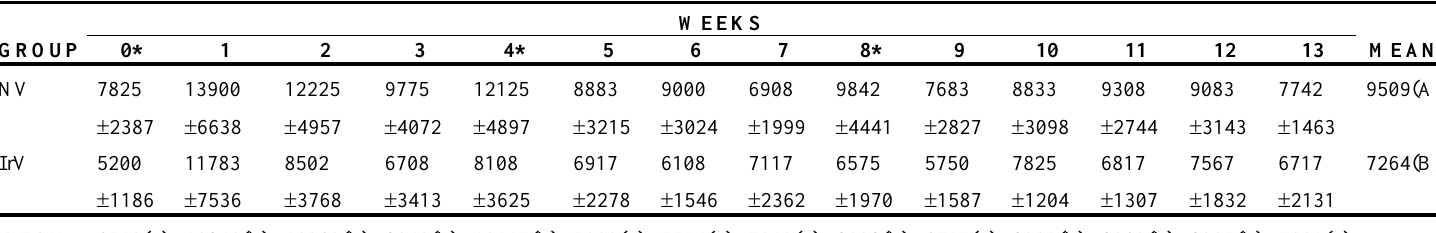
Table 1. Means and standard deviation of leukocytes count (cells/ µ L) in sheep (n=12) inoculated at days zero, 30, and 60 with natural (NV) and Cobalt -irradiated (IrV) crotalic venom. 60